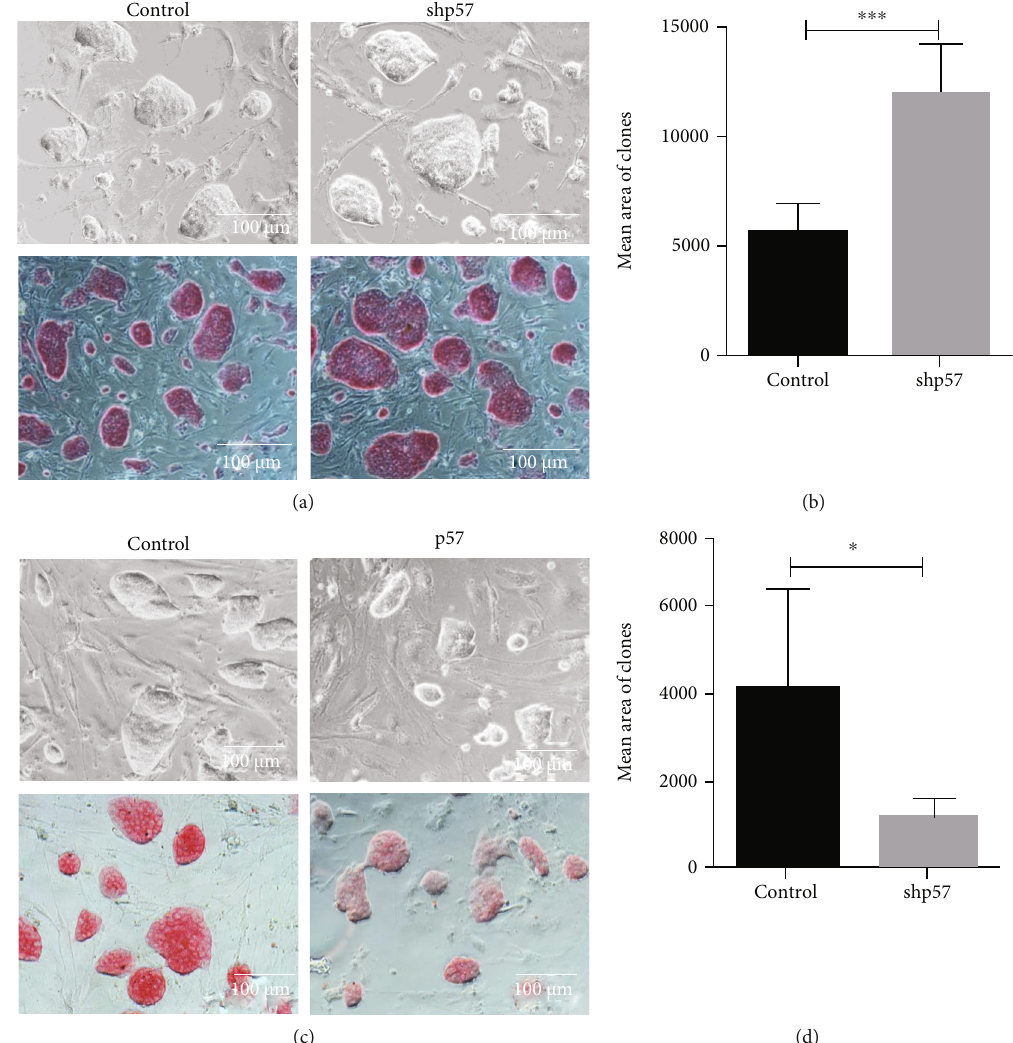
Figure 3: p57 suppressed the clone areas of mESCs in vitro . (a) Representative image of morphology and AP expression pro fi les of control and p57 knockdown (shp57) mESCs cultured for 48h. (b) Area analysis of clones of control ( n = 5 ) and p57 knockdown (shp57, n = 5 ) mESCs. (c) Representative image of morphology and AP expression pro fi les of control and p57-overexpressing (p57) mESCs cultured for 48h. (d) Area analysis of clones of control ( n = 5 ) and p57-overexpressing (p57, n = 5 ) mESCs. Scale bar = 100 μ m. ∗ P < 0 : 05 and ∗∗∗ P < 0 : 001